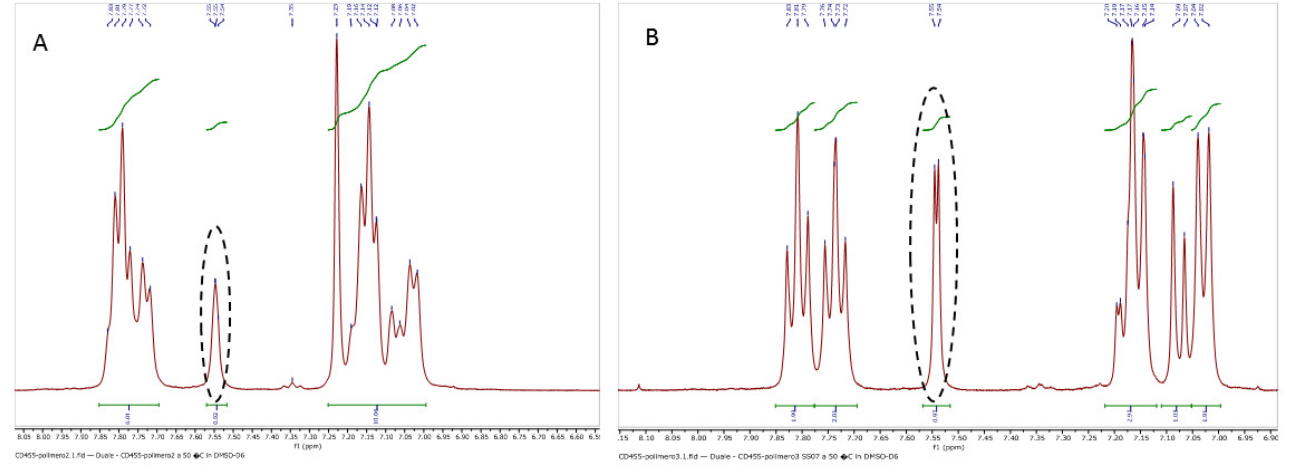
Figure 2. NMR spectra of sulfonated PEEK samples ( A ) SA-01 (degree of sulfonation: 61.6%) and ( B ) SA-02 (degree of sulfonation: 98.9%).